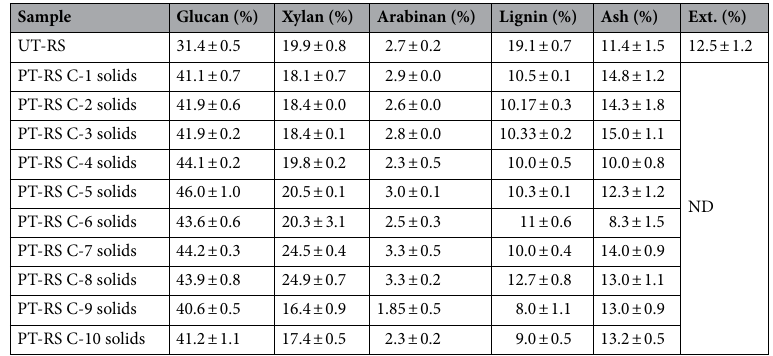
Table 1. Composition analysis of untreated (UT-RS) and pretreated rice straw (PT-RS) samples during subsequent solvent reuses (C1–C10); all of the percentage compositions of raw and pretreated solid samples were calculated based on their dry weights. Ext . extractives, ND not determined.